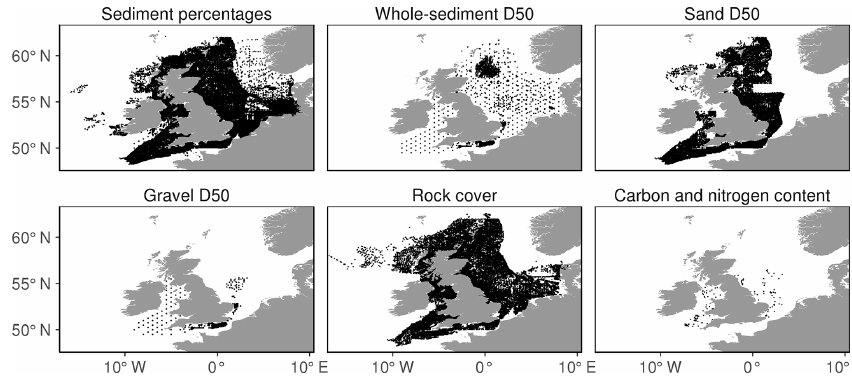
Figure 2. Locations with field estimates of each seabed sediment parameter. Data sources are listed in Table